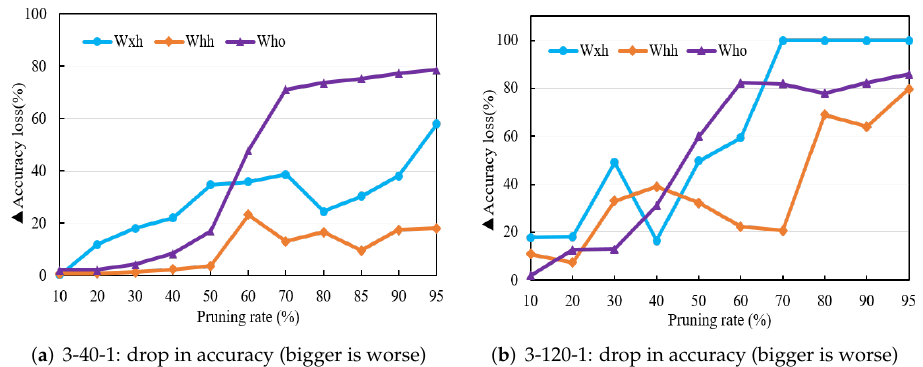
Figure 8. Performance loss after pruning each layer connection in the pre-trained models with different hidden units; a smaller loss represents less sensitivity to the same pruning ratio.